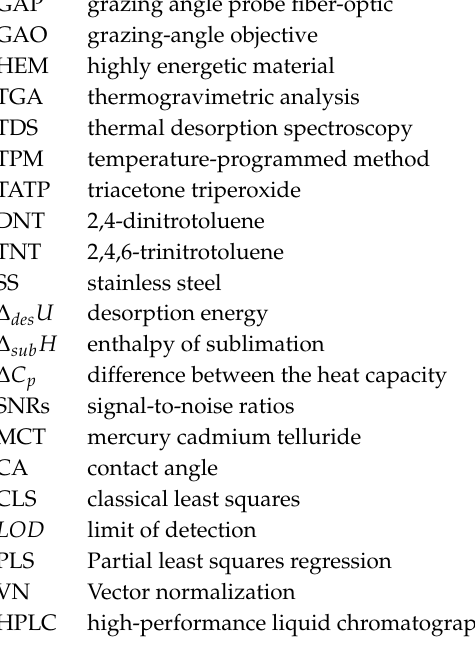
calculated from TGA measurements, Figure S8: Verification of the surface concentration of RDX by HPLC; Calibration curve for RDX by HPLC, Table SIV: Kinetics parameters and thermodynamic functions calculated from GAP, TGA, and TPM, Figure S9: (a) Plot of absorbance vs. wavenumber for RDX in KBr from macro-FTIR; (b) plot of Delta R/R vs. wavenumber of layers of RDX from GAP at 80 ◦ C; (c) plot of Delta R/R vs. wavenumber of layers of RDX from GAP to 25 ◦ C; (d) plot of Delta R/R vs. wavenumber of layer of RDX from GAO to 25 ◦ C; (e) Plot of Delta R/R vs. wavenumber of SS substrate by GAO, Table SV: Signal to noise for GAP and GAO, Table SVI: Comparison of calculated Enthalpy of sublimation with literature values for TATP, Equations: Calculation of enthalpy and its uncertainties in the media temperature Figure S10: The plot of droplet size vs. surface concentration for TNT. The figure shows the standard deviation, (black line), first and third quartile (orange), and quadratic fit (dotted line), Figure S11: The plot of droplet size vs. surface concentration for 2,4-DNT. The figure shows the standard deviation, (black), first and third quartile (orange) and quadratic fit (dotted line), Figure S12: Arrhenius plots of TGA data used to obtain the sublimation rates for Benzoic